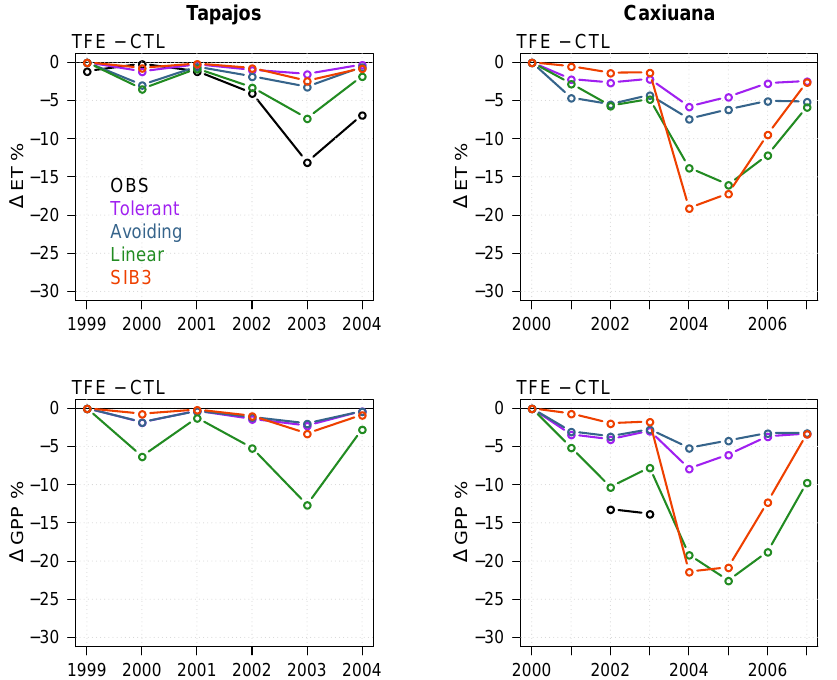
Figure 7. Annual mean differences (throughfall exclusion (TFE) plot minus control (CTL) plot) in simulated evapotranspiration (ET) (top) Figure 7 – Annual mean differences (TFE plot minus CTL plot) in simulated ET (top) with ISBA CC and Markewitz’s with ISBA CC and Markewitz’s model outputs as a proxy (Markewitz et al., 2010). Annual differences (exclusion plot minus control plot) in model outputs as proxy (Markewitz et al 2010). Annual differences (exclusion plot minus control plot) in simulated GPP simulated gross primary production (GPP) (bottom) with ISBA CC and SPA’s model outputs as a proxy (Fisher et al., (bottom) with ISBA CC and SPA’s model outputs as proxy (Fisher et al 2007).